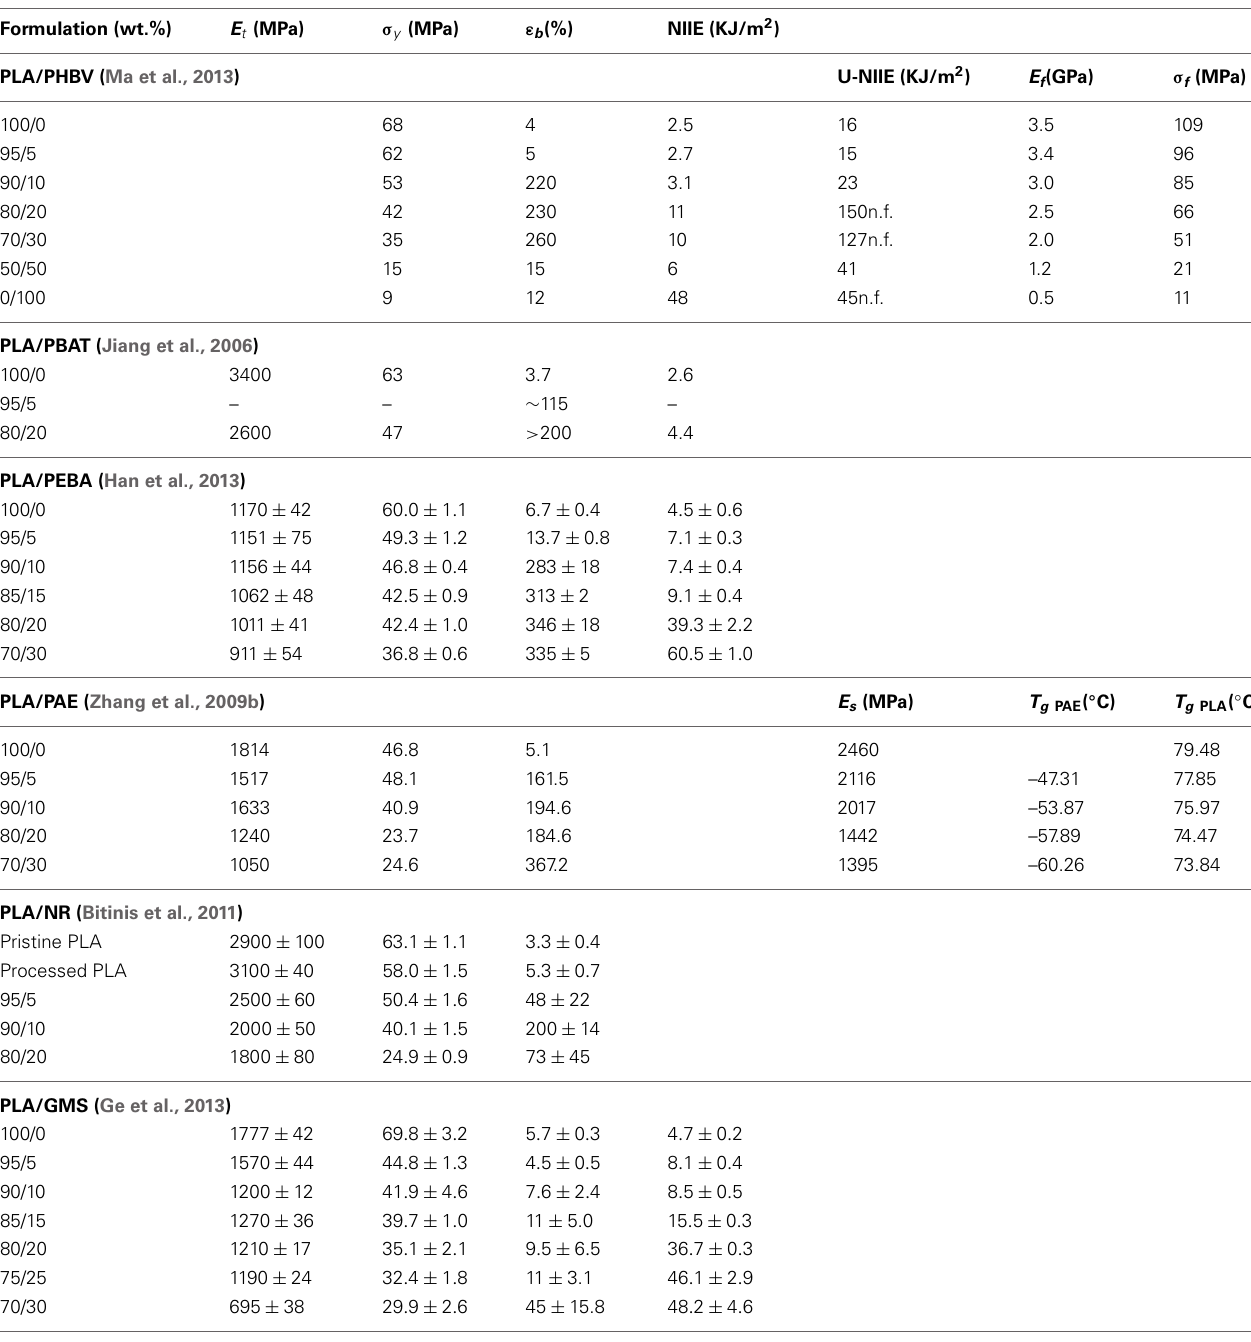
Table 8 | Mechanical properties of different PLA blends with biodegradable flexible/soft polymers. Formulation